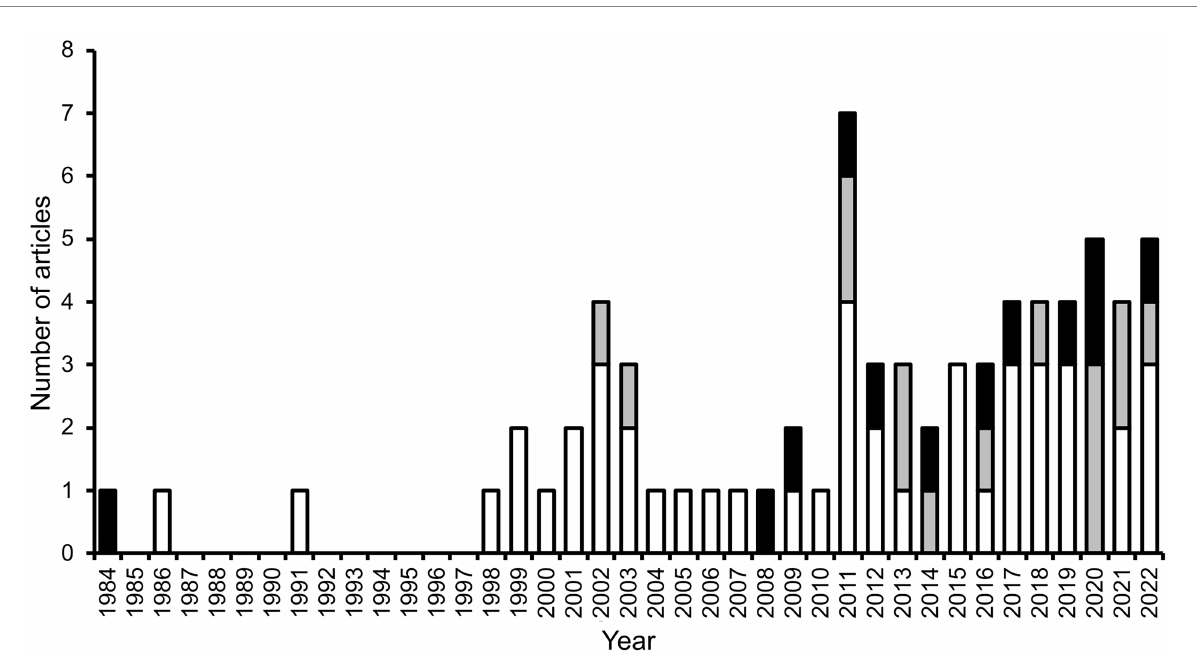
FIGURE 2 Number of scientific articles (excluding reviews) published per year, which include information on some aspect related to the secondary dispersal by dung beetles of seeds embedded in the feces of vertebrates (mostly mammal dung), in tropical (white and grey bars) and extratropical biomes (black bars). Grey bars represent studies that use dung beetles as a focal taxon in applied biodiversity conservation research (all carried out in the tropics; see Biodiversity studies using dung beetles as a focal